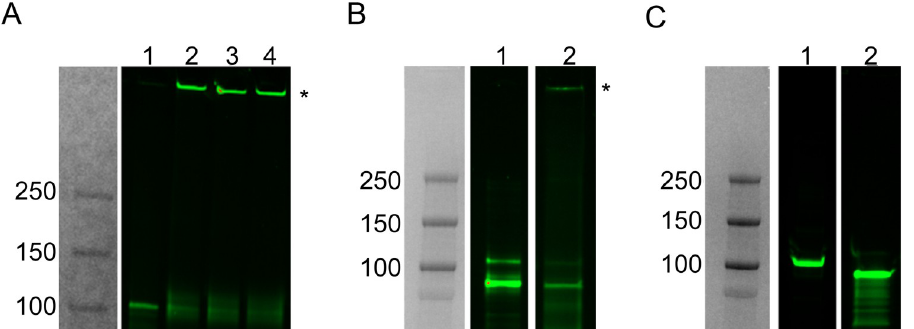
Fig 7. Vpb4Da2 forms an oligomer at acidic pH in the presence of the BBM from WCR (Full SDS-PAGE figures are depicted in supporting information). (A) Trypsin-processed Vpb4Da2 (tryptic core) forms a reversible oligomer in the presence of WCR BBM as shown in the gel following treatment with a homo-bifunctional cross-linker (BS3). BS3 titration at 0, 1, 2, and 5 mM are in lanes 1, 2, 3, and 4, respectively. Reactions were carried out at pH 6.0 and at room temperature. The oligomerized Vpb4Da2 tryptic core is indicated by the asterisk at the entrance of gel wells. (B) The Vpb4Da2 tryptic core forms a BBM bound oligomer in the absence of crosslinker at pH 6.0 and 37˚C. The Vpb4Da2 tryptic core without BBM is shown as a monomer (lane 1). An SDS-resistant oligomer, asterisk (lane 2), is formed in the presence of WCR BBM. (C) The trypsin-processed Vpb4Da2 disabled insecticidal protein (DIP)